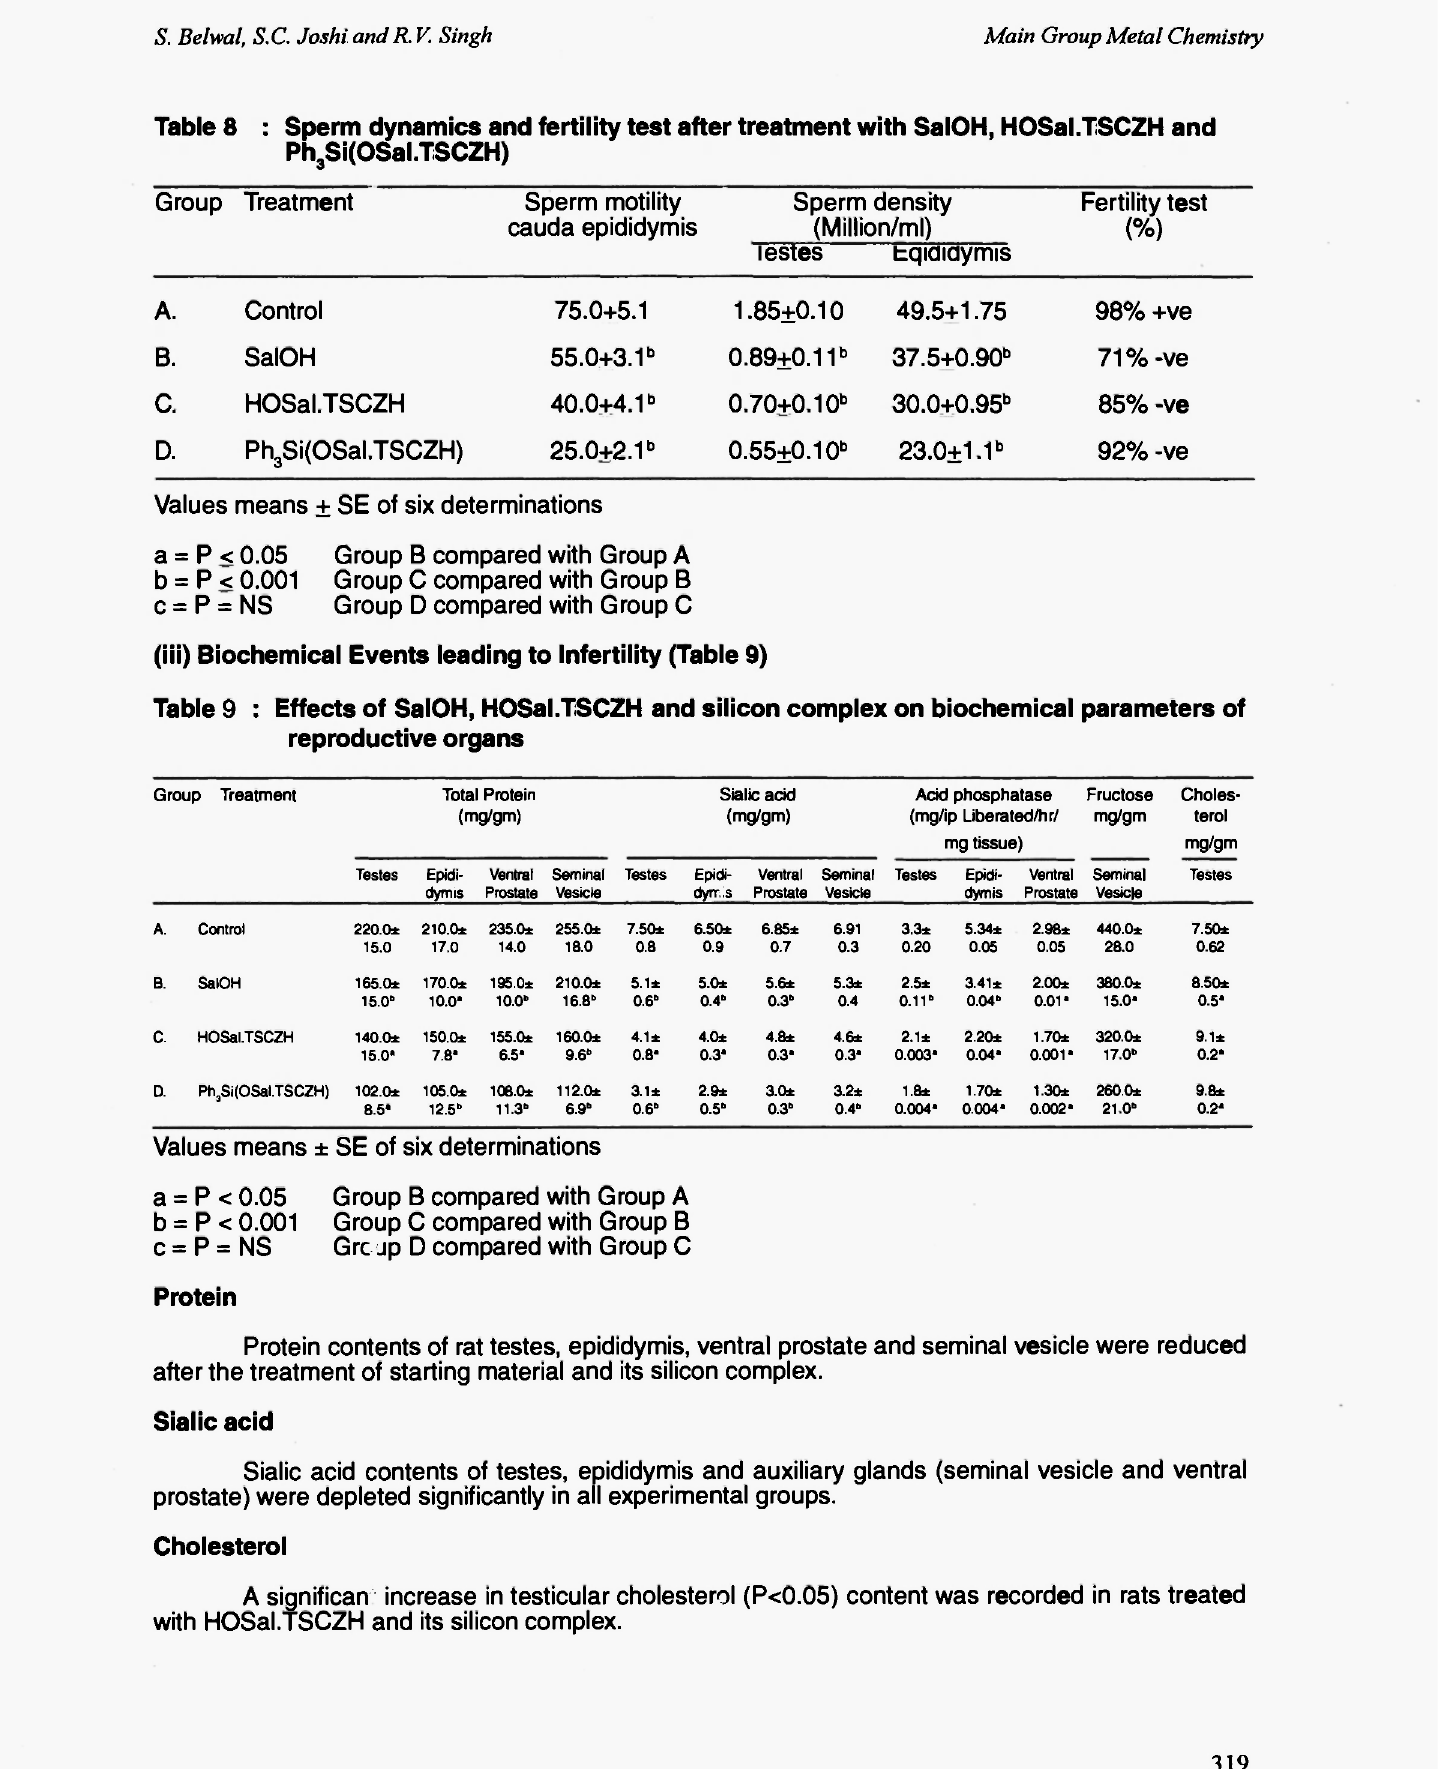
Table 8 : Sperm dynamics and fertility test after treatment with SalOH, HOSal.TSCZH and Ph,Si(OSal.TSCZH)